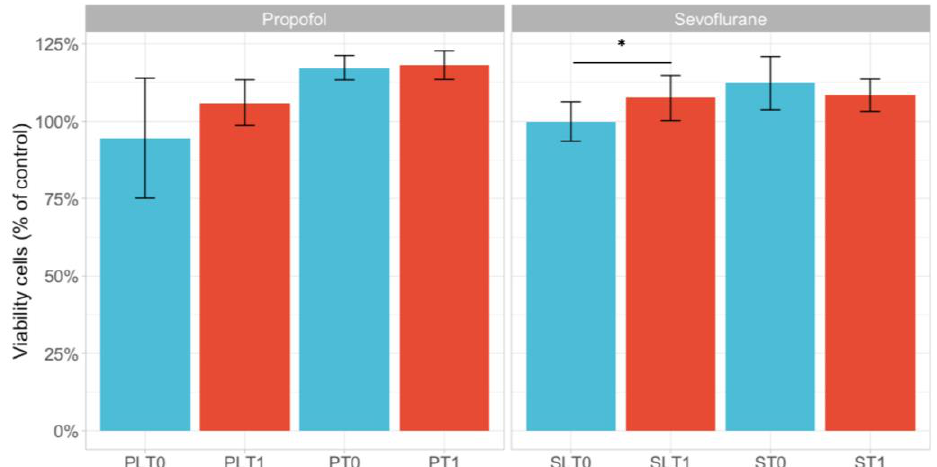
Figure 1. An evaluation of cellular viability levels on the HCT-116 cell line using the MTT assay of serum from patients in our study groups. The data are represented as the mean +/ − standard deviation and the asterisks (*) indicate significant difference at p < 0.05. The study groups are as follows: TIVA with lidocaine (group PL, before surgery—T0 and after surgery—T1); TIVA (group P, before surgery—T0 and after surgery—T1); sevoflurane with lidocaine (group SL, before surgery—T0 and after surgery—T1); and sevoflurane (group S, before surgery—T0 and after surgery—T1).